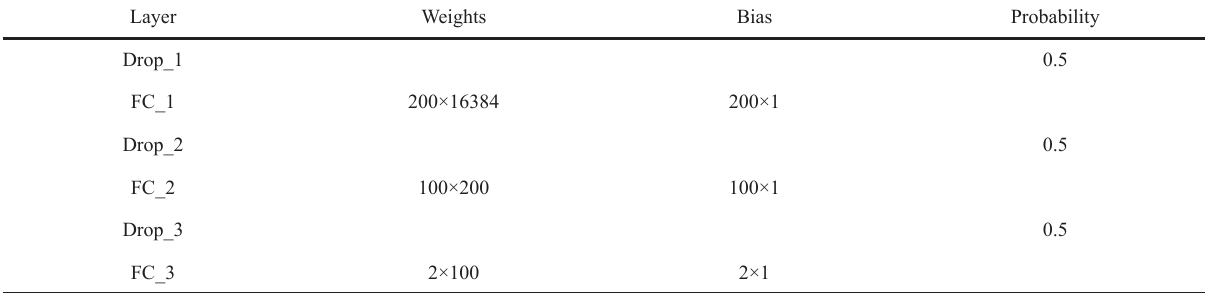
Table 4. Fully-connected